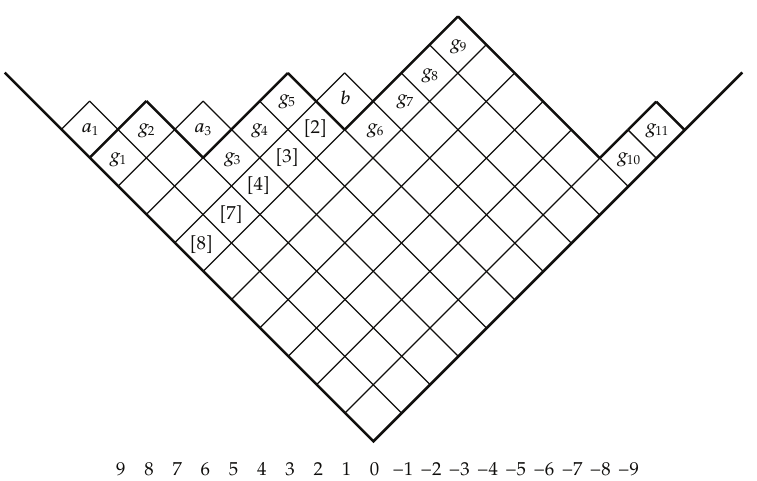
Figure 2: The partition enclosed by the thick lines is λ (cid:7) (cid:3) 10 , 10 , 8 , 8 , 8 , 6 , 6 , 6 , 6,1 , 1 (cid:4) . If k (cid:7) 6 then A (cid:3) λ,< 6 (cid:4) (cid:7) { a 1 ,a 3 } , R (cid:3) λ,< 6 (cid:4) (cid:7) { g 2 ,g 5 } , and ev λ (cid:3) s 6 (cid:4) (cid:7) (cid:3)(cid:5) 2 (cid:6) / (cid:5) 3 (cid:6)(cid:4)(cid:3)(cid:5) 3 (cid:6) / (cid:5) 4 (cid:6)(cid:4)(cid:3)(cid:5) 4 (cid:6) / (cid:5) 5 (cid:6)(cid:4)(cid:3)(cid:5) 7 (cid:6) / (cid:5) 8 (cid:6)(cid:4)(cid:3)(cid:5) 8 (cid:6) / (cid:5) 9 (cid:6)(cid:4) (cid:7) (cid:4) − c (cid:3) b (cid:4)(cid:6)(cid:5) c (cid:3) g (cid:4) − c (cid:3) b (cid:4)(cid:6)(cid:4) / (cid:3)(cid:5) c (cid:3) a (cid:4) − c (cid:3) b (cid:4)(cid:6)(cid:5) c (cid:3) a (cid:4) − c (cid:3) b (cid:4)(cid:6)(cid:4) . The factors in the numerator (cid:3)(cid:5) 2 (cid:6) / (cid:5) 5 (cid:6)(cid:4)(cid:3)(cid:5) 7 (cid:6) / (cid:5) 9 (cid:6)(cid:4) (cid:7) (cid:3)(cid:5) c (cid:3) g 5 2 3 1 of the first expression are displayed. These are the q -integers corresponding to the hook lengths of the boxes in the same column as the addable box b in row